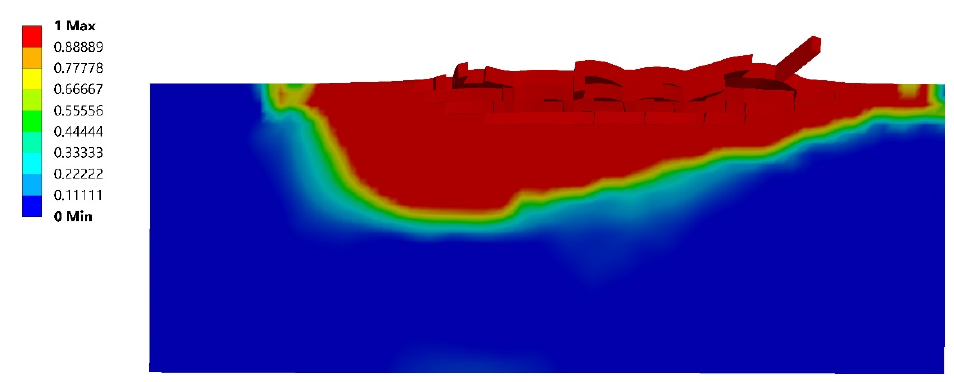
Figure 7. Damage of a 35 ◦ tip angle AoA 30 ◦ projectile bouncing off of the target. The decrease in damage at a higher AoA, like 90 ◦ , is caused by the fact that the extent of damage, in this case, is limited to the area around the path the projectile created when passing through the target, which can be seen in Figure 8.